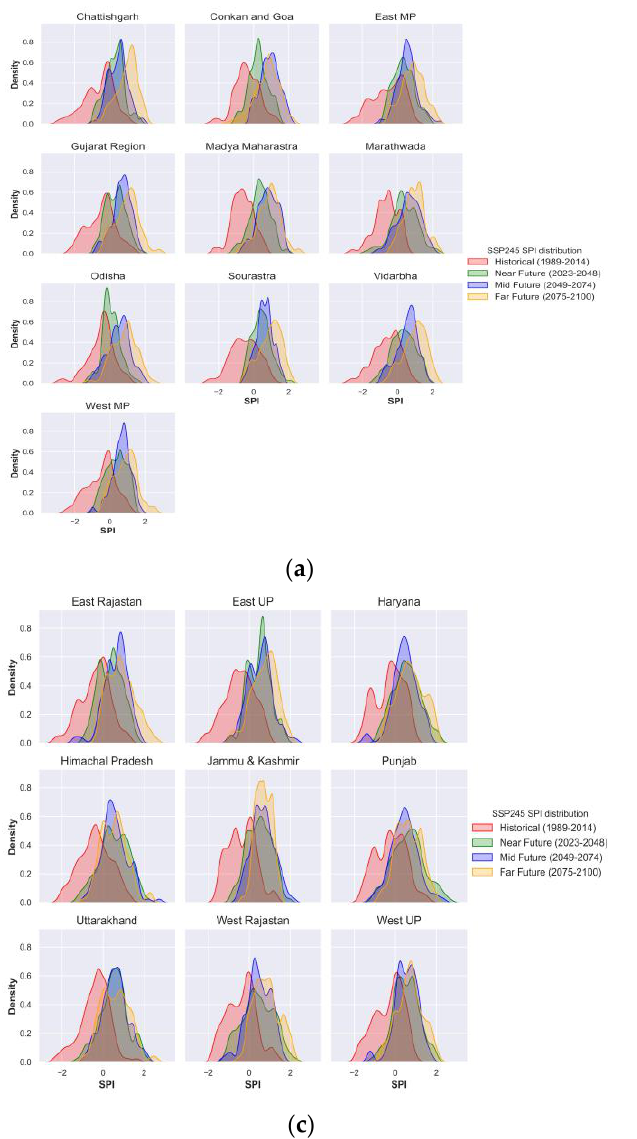
Figure 10. CMIP6 SSP126 scenarios 12-month Standard Precipitation Index (SPI) PDF plot at mete- orological subdivision level ( a ) Central India, ( b ) East and Northeast India, ( c ) Northwest India, and ( d ) South Peninsula India for near, mid, and far future.